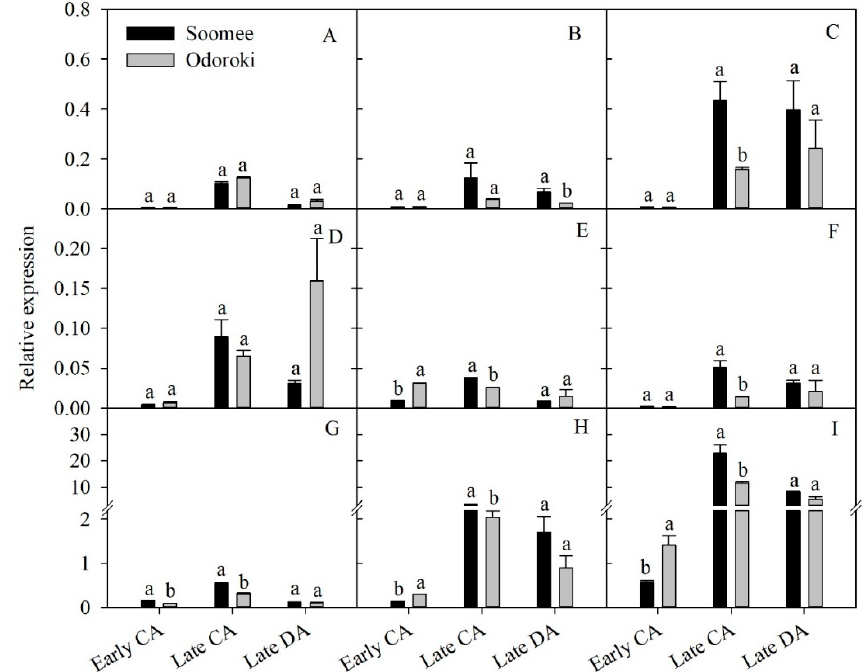
Figure 6. Comparative gene expressions of the selected nine DEGs up- and down-regulated during cold acclimation (CA), from early to late CA, and deacclimation (DA), from late CA to late DA, respectively, between the ‘Soomee’ and ‘Odoroki’ peach tree shoots. The DEGs were selected based on the significance of fold change during CA and DA. Vertical bars are the standard errors of the means ( n = 3). Different letters indicate significant differences within the same physiological stages using the Student’s t -test at p < 0.05. ( A ), non-symbiotic hemoglobin (LOC18766910); ( B ), squalene monooxygenase (LOC18768153); ( C ), polygalacturonase inhibitor (LOC18769194); ( D ), tonoplast dicarboxylate transporter (LOC18780397); ( E ), late embryogenesis abundant protein 2 (LOC18784088); ( F ), extracellular ribonuclease LE (LOC18793247); ( G ), bidirectional sugar transporter SWEET1 (LOC18768928); ( H ), 14 kDa proline-rich protein DC2.15 (LOC18785901); ( I ), pEARLI1-like lipid-transfer protein 3 (LOC109947416).